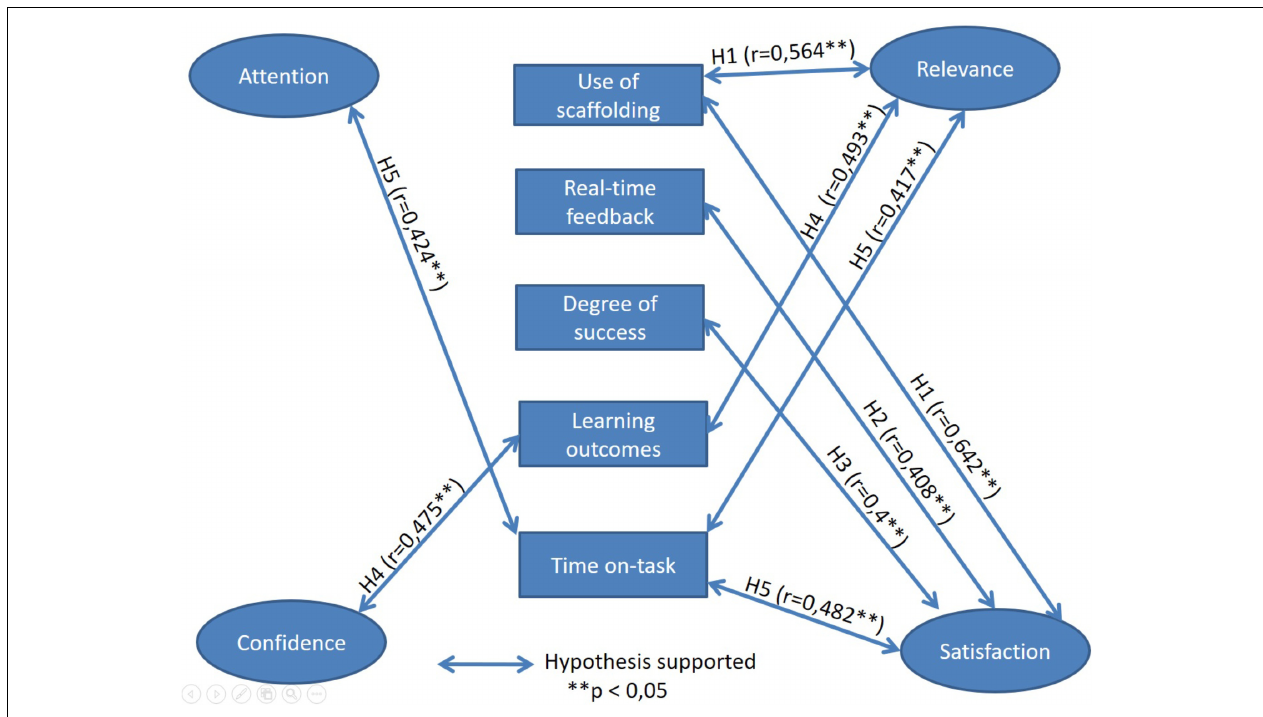
FIGURE 3 | Validated research model for hypotheses H1, H2, H3, H4, and